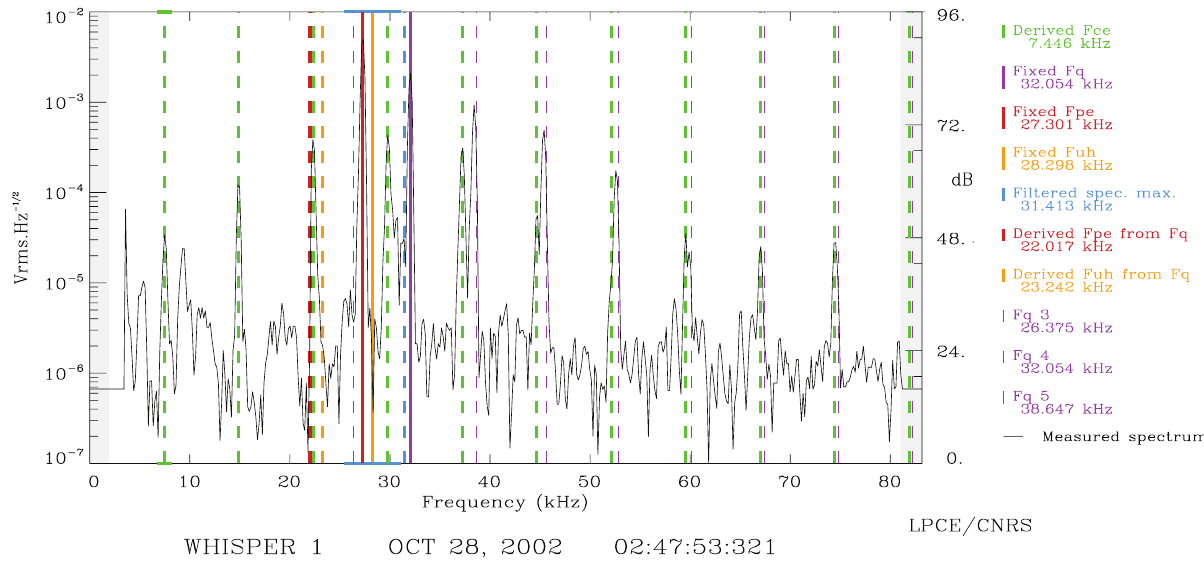
Fig. 12. Sounder data measured by the WHISPER instrument on the C1 spacecraft showing the labelled